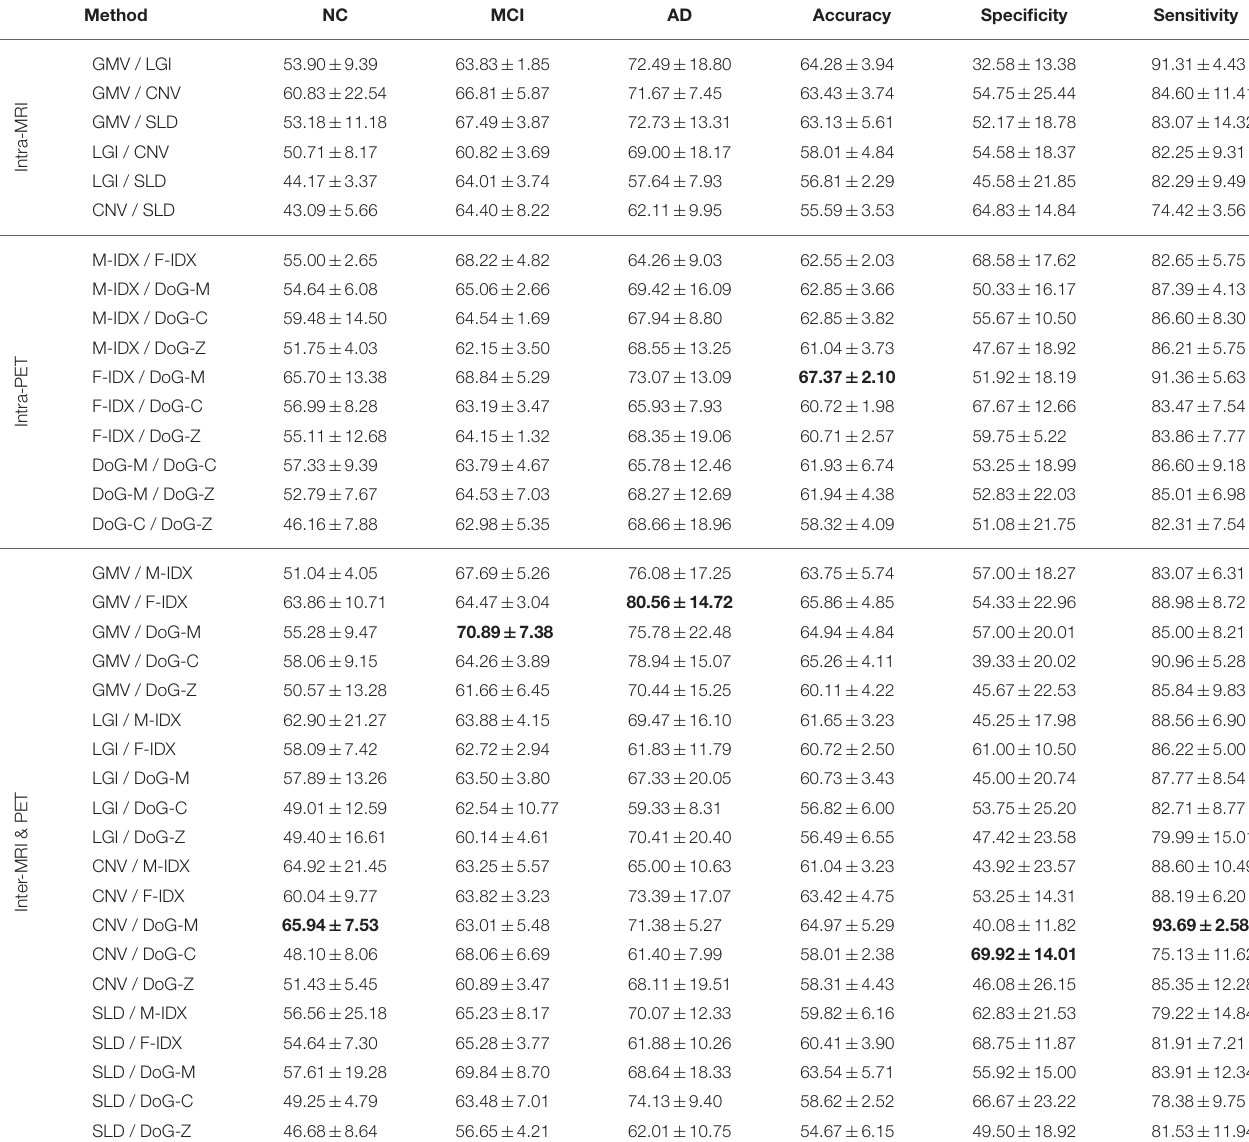
TABLE 3 | The classification performance of the 36 combinations of the multimodal neuroimaging biomarkers. Method Accuracy Specificity Sensitivity